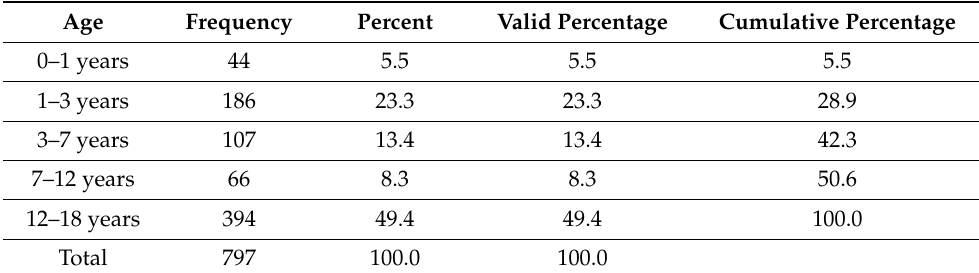
Table 1. Incidence of poisoning by age groups in the studied